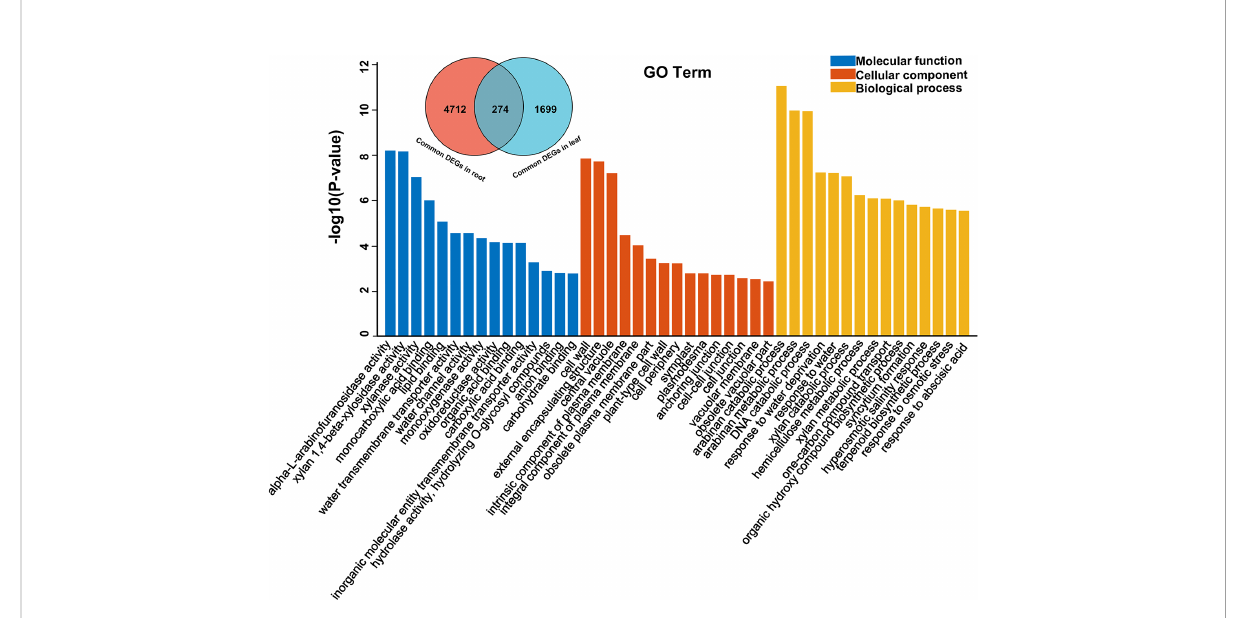
FIGURE 3 GO enrichment bar chart of 274 common DEGs among root and leaf.